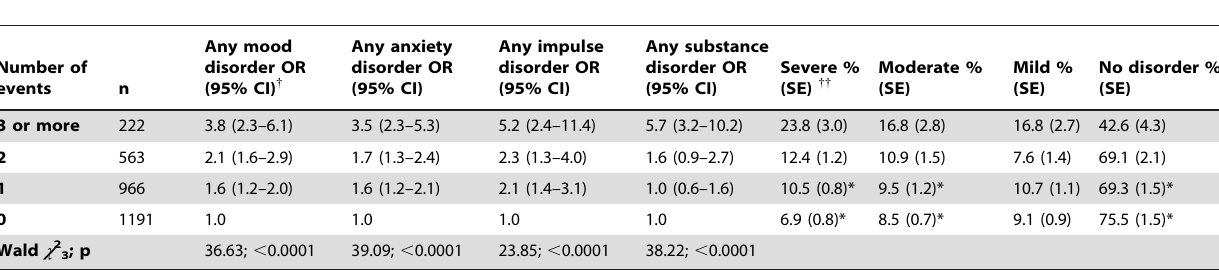
Table 3. Associations of exposure to crime-related 1 traumatic events with 12-month DSM-IV/WMH-CIDI disorders and disorder